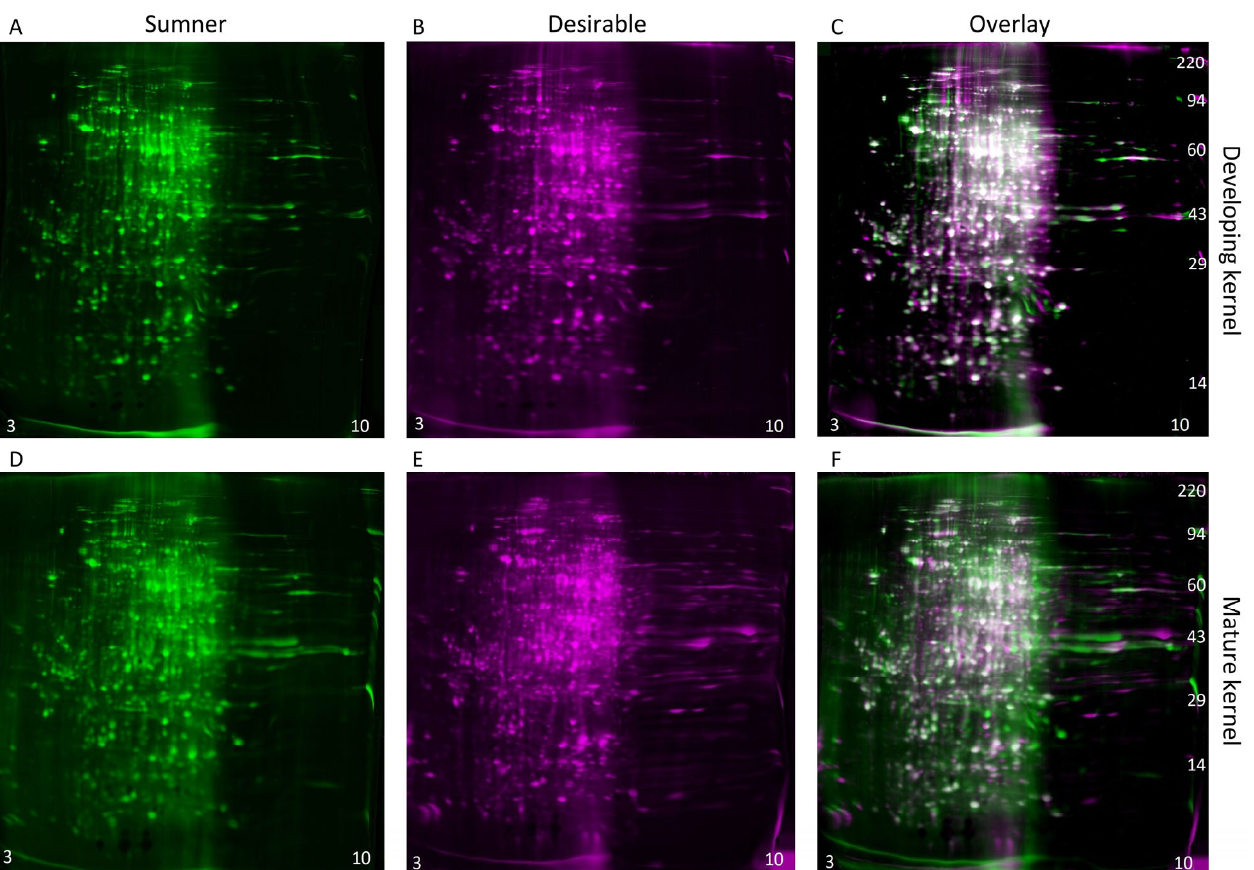
Figure 7. Comparison of cultivars within time points by two-dimensional gel electrophoresis and silver staining. ( A – C ) Developing (9/18) pecan nuts. ( D – F ) Mature (9/25) pecan nuts. ( A , D ) Protein extract from Sumner pecan nuts shown in green coloration. ( B , E ) Protein extract from Desirable pecan nut shown in magenta coloration. ( C , F ) Overlay of 2-D gel analysis of the proteins of Sumner vs. Desirable pecan nuts. Silver-stained spots appear white when equally abundant in both gels. Relatively acidic proteins (pH 3) accumulate to the left and relatively basic proteins (pH10) accumulate to the right of each gel, and molecular weight markers are indicated on the right-most panel of each montage.